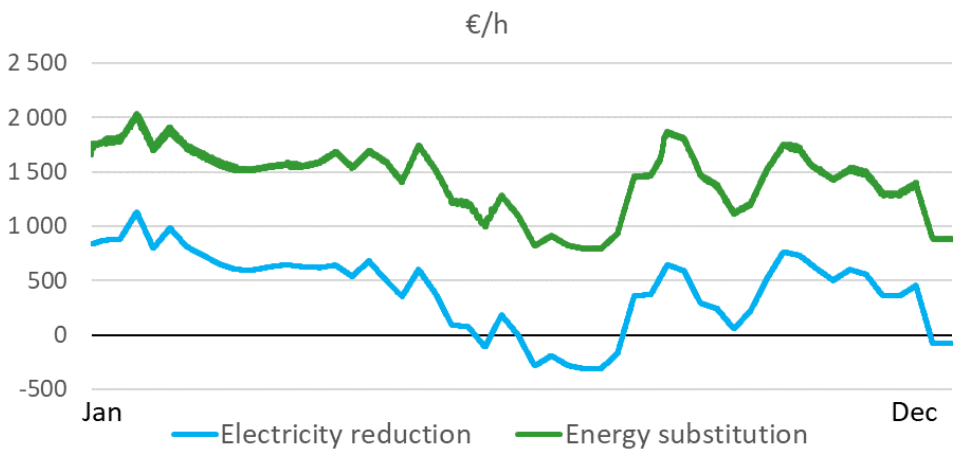
Figure 2. A comparison between the electricity reduction and energy substitution case with the reference case as the base.